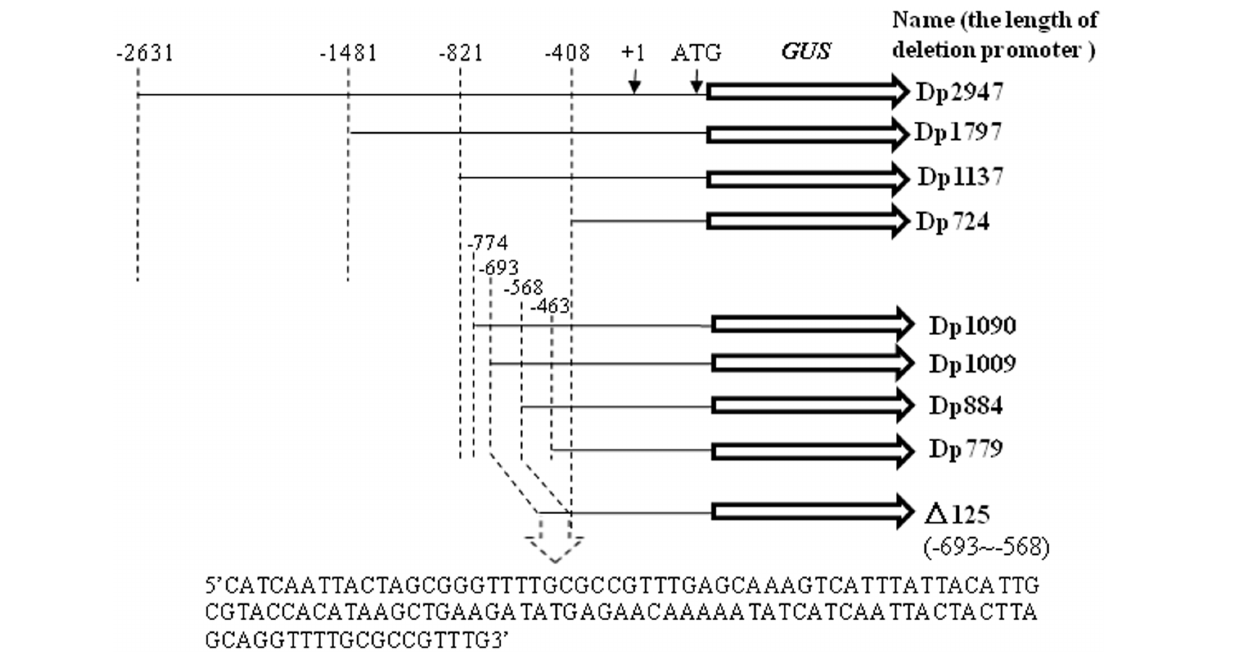
FIGURE 1 | Schematic depiction of deletion fragments generated in the study. Successive 5 (cid:48) promoter truncations were fused to a GUS reporter. The putative transcription start site was designated as “+1”.